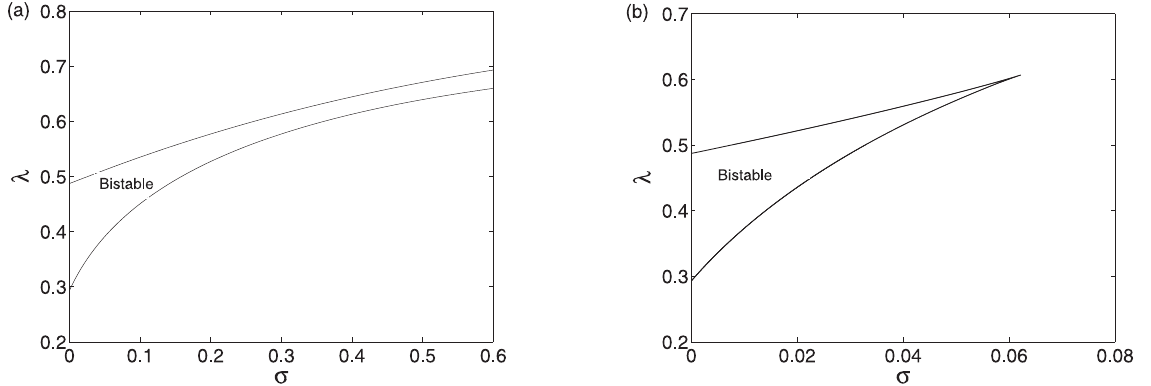
Figure 5. The bistability region of both models. (a) The bistability region of model I. (b) The bistability region of model II. The parameter values are d ~ 0 : 6 , c ~ 0 : 2 , a ~ 2 , m ~ 0 : 5 , b ~ 0 : 5 , and r ~ 40 .